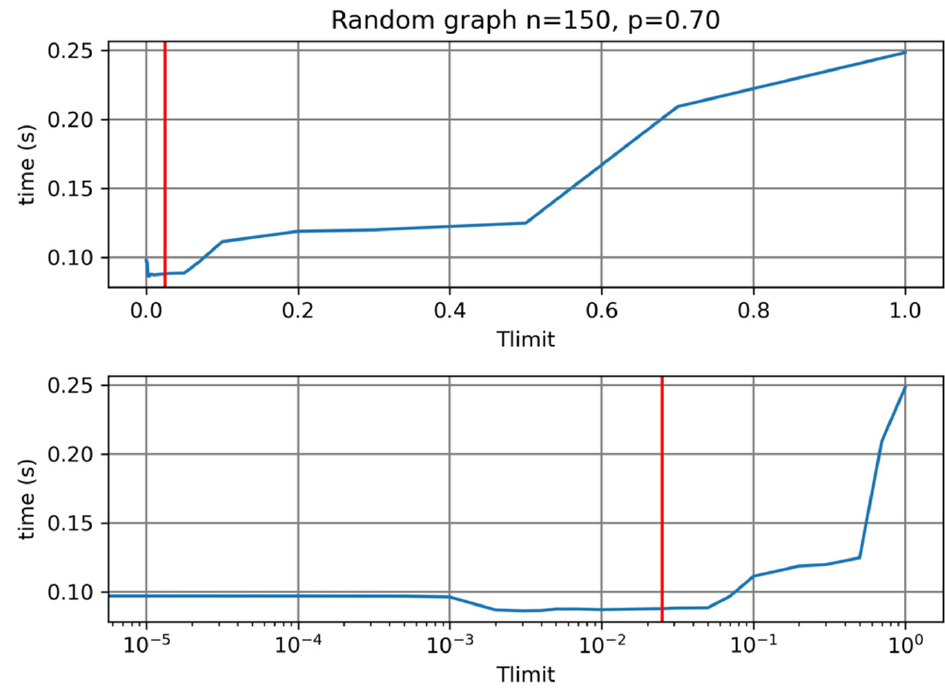
Figure 2. Time necessary for MCQD to find the maximum clique on a random graph with 150 nodes and density p = 0.7. The red line represents the default value (0.025) of the MCQD algorithm.